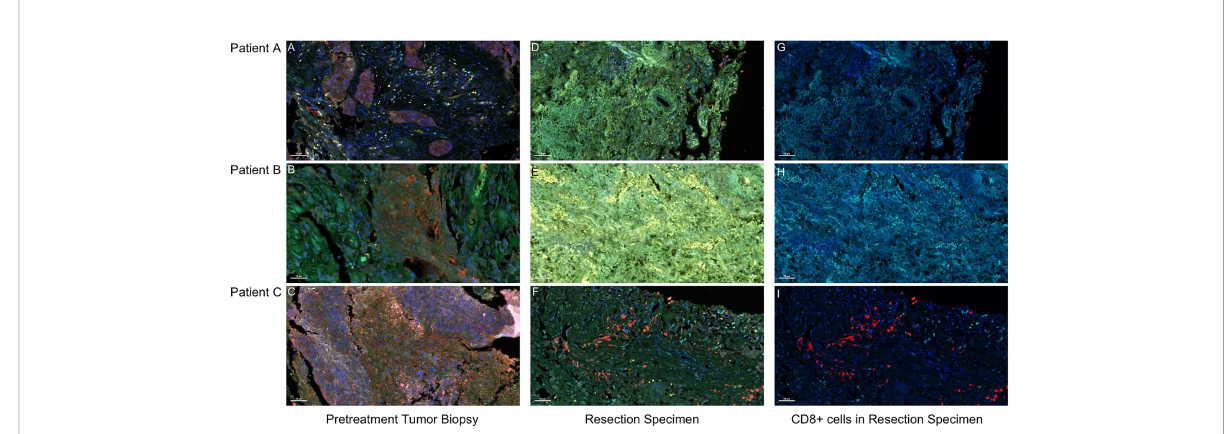
FIGURE 3 Presence of CD 68+ macrophages, CD8+ T cells, and FoxP3+ Treg cells in pretreatment and surgical specimen detected by multiplex fl uorescent immunohistochemistry. Visible structures include cytokeratin-positive tumor cells (red), PD-1+ cells (orange), PD-L1+ cells (green), CD68+ macrophages (white), CD8+ T cells (cyan), and FoxP3+ regulatory T cells (yellow). (A – C) Pretreatment tumor biopsy tissues. After two doses of camrelizumab plus chemotherapy, the surgical specimens of patients A and B who achieved MPR contained an in fl ux of CD8+ T cells (G, H) , and the presence of macrophages, Treg cells, and PD-1 and PD-L1+ immune cells were more common in the tumor area (D, E) . By contrast, in patient C who had no MPR, the tumor immune response was not obvious, and the amount of PD-1 and PD-L1+ immune cells was reduced after treatment (F, I) . Scale bar, 50 m